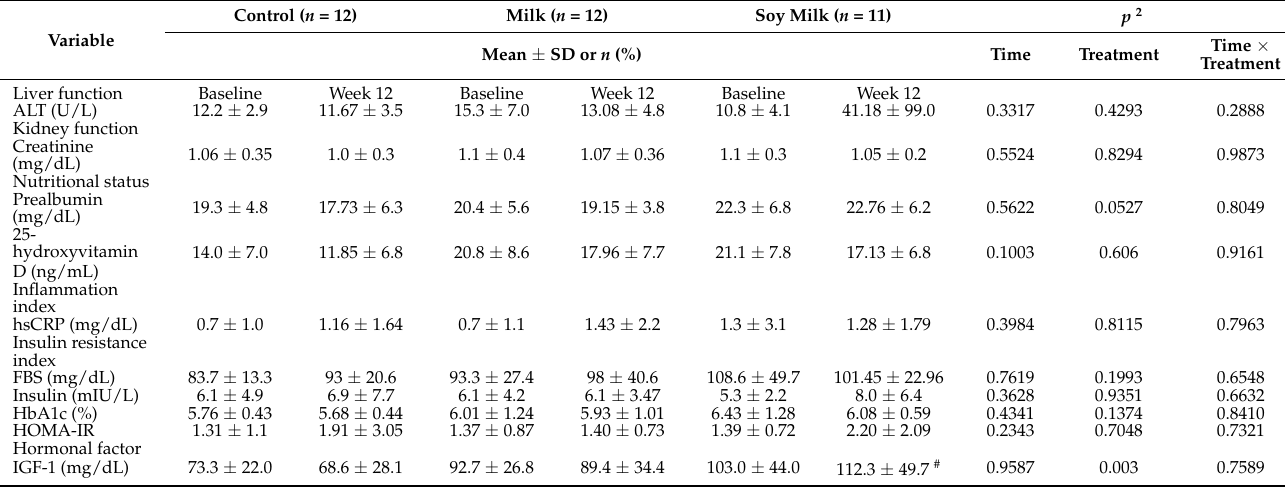
Table 2. Effects of milk or soy milk combined with resistance exercise on clinical laboratory data of very old nursing home residents with sarcopenia 1